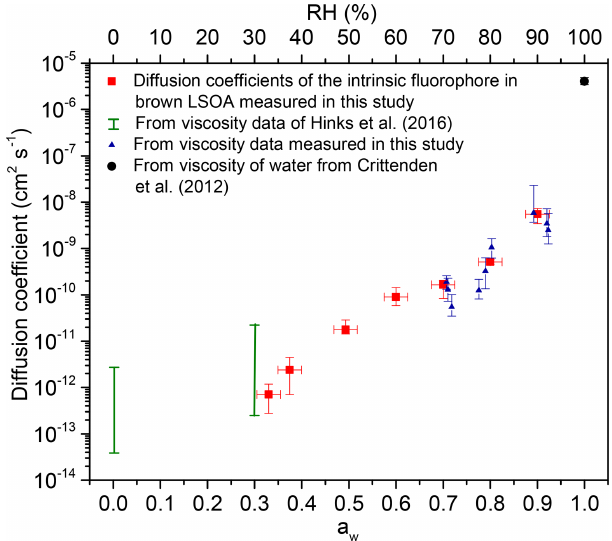
Figure 5. Measured and calculated diffusion coefficients in brown LSOA as a function of a w (primary x axis) and RH (secondary x axis). The red squares show the measured diffusion coefficients of intrinsic fluorophores in brown LSOA. The blue triangles show the calculated diffusion coefficients of the intrinsic fluorophore in brown LSOA based on viscosities measured in this study using the bead-mobility technique and the Stokes–Einstein equation. The y error bars for the diffusion coefficients measured in this study (red squares) and the diffusion coefficients calculated from bead- mobility viscosity measurements (blue triangles) show the highest and lowest values measured. The green vertical bars depict the high- est and the lowest limit of calculated diffusion coefficients of brown LSOA based on viscosity measurements from Hinks et al. (2016) and the Stokes–Einstein equation. The black circle depicts the cal- culated diffusion coefficient of the intrinsic fluorophore in pure wa- ter based on viscosity measurements of Crittenden et al. (2012) and the Stokes–Einstein equation. The uncertainties for the calculated diffusion coefficients take into account the uncertainty of the hy- drodynamic radii of the diffusing molecules (4.5 to